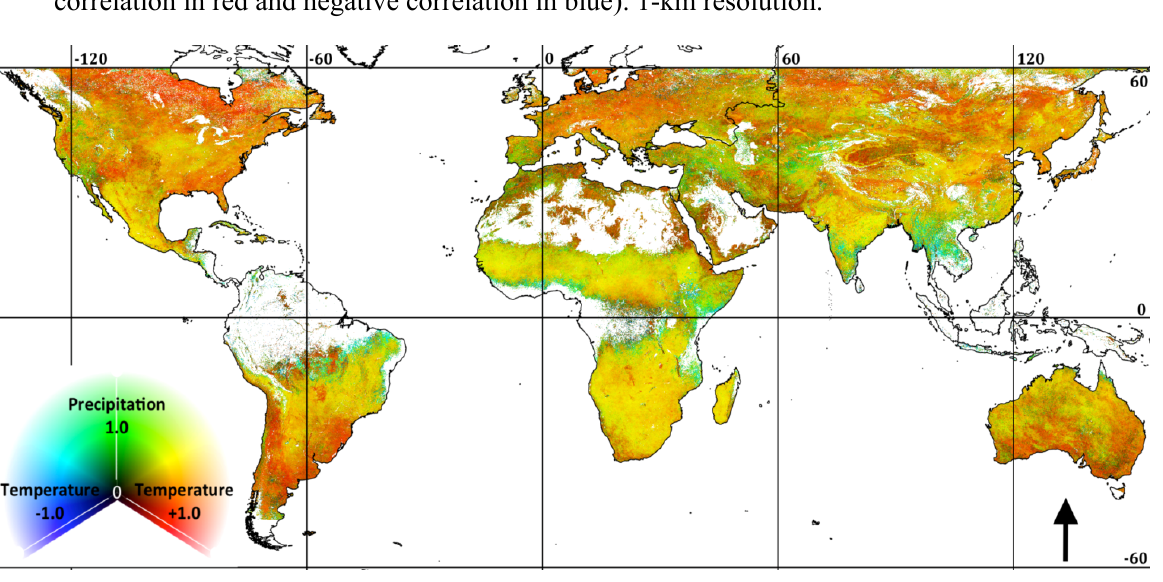
Figure 5. Correlation of EVI and precipitation (green), EVI and temperature (positive correlation in red and negative correlation in blue). 1-km resolution.